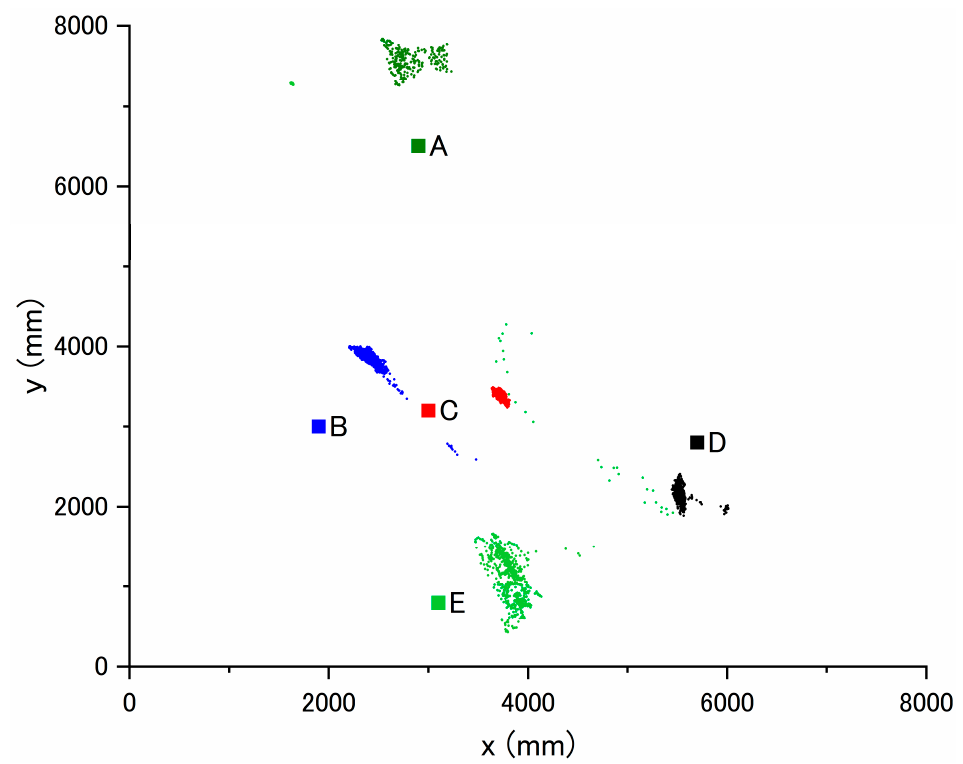
Figure 4. Results of accuracy verification. A-E shows each point of (A-E) shown in Figure 1. The small dots indicate the position measured by the Wi-Fi RTT at each measurement point. The squares indicate the actual position of each measurement point. The measurement results from the Wi-Fi RTT are concentrated in a specific range at each point, and the precision is considered to be relatively high. The level of accuracy is considered to be sufficient for the purpose of this study. Sensors 2021 , 21 , x FOR PEER REVIEW Table 3. Measurement error at each point.